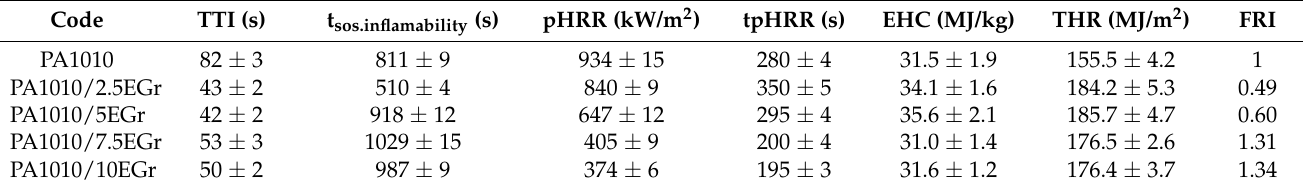
Table 7. Summary of thermal parameters obtained with the calorimetric cone test (CCT) on the PA1010 and EGr